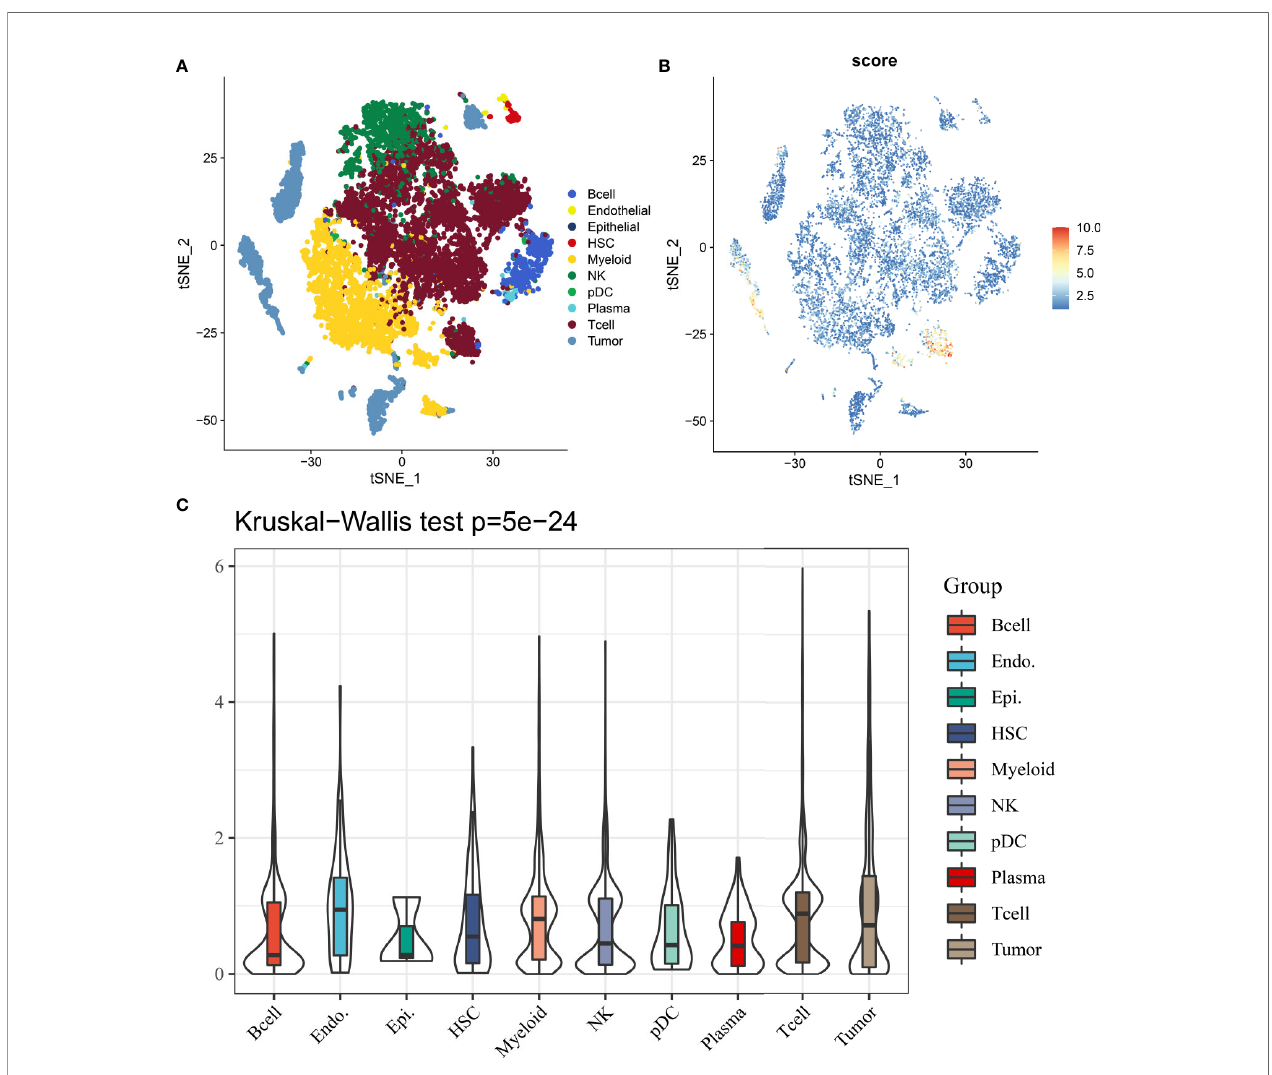
FIGURE 8 | The distribution and expression of DDR subtype signature in HCC. (A) The percentage of each type of cells in HCC. (B) The distribution of each type and DDR score expression in HCC. (C) DDR scores in different cells are